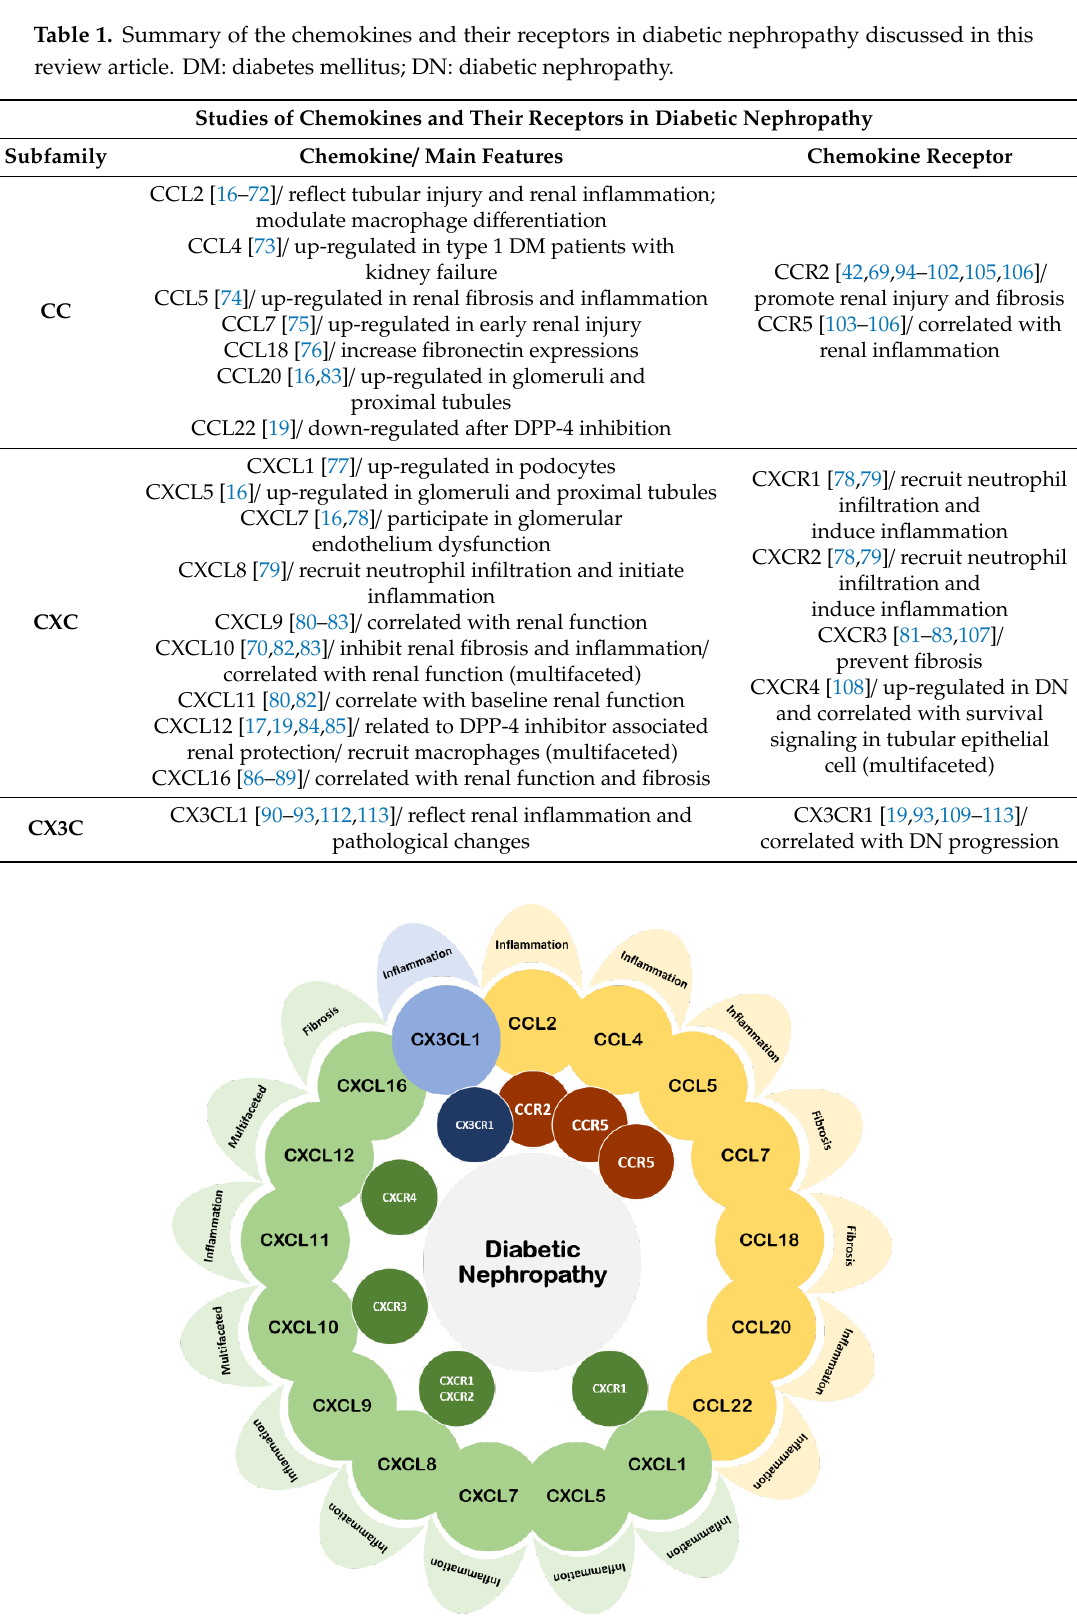
Figure 1. Correlation of the chemokines and their receptors in diabetic nephropathy discussed in this review article. Most of them are pro-inflammation or pro-fibrosis in diabetic nephropathy.